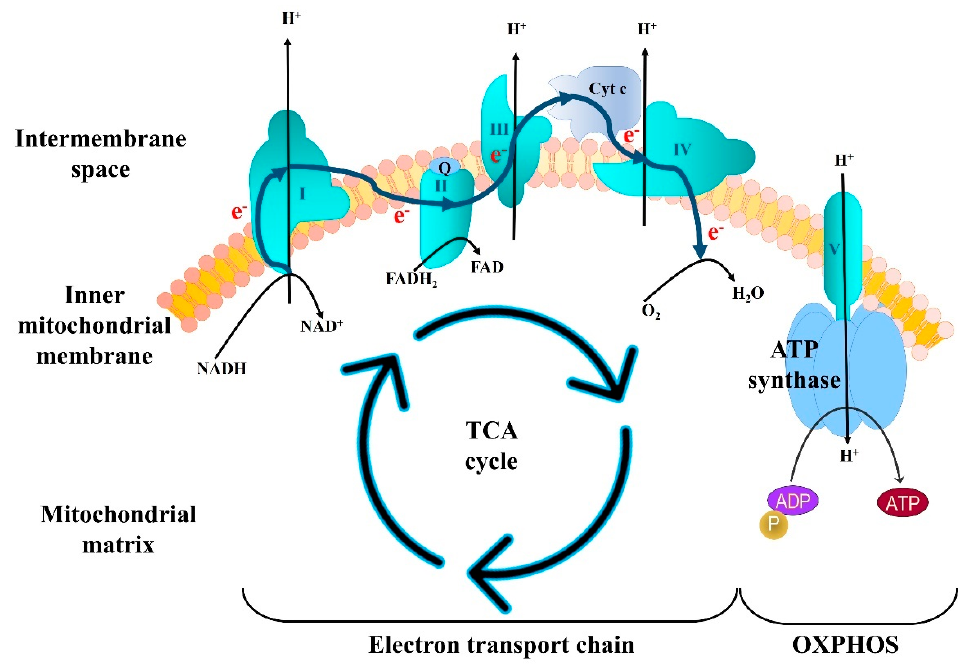
Figure 2. Mitochondrial energy metabolism. In healthy cells, the tricarboxylic acid (TCA) cycle works to reduce nicotinamide adenine dinucleotide (NADH) and oxidize succinate molecules, which are further used by the electron transport chain (ETC) to generate an electrochemical gradient between the inner membrane space and matrix. Mitochondrial Complex V (ATP synthase) uses this gradient to produce ATP.